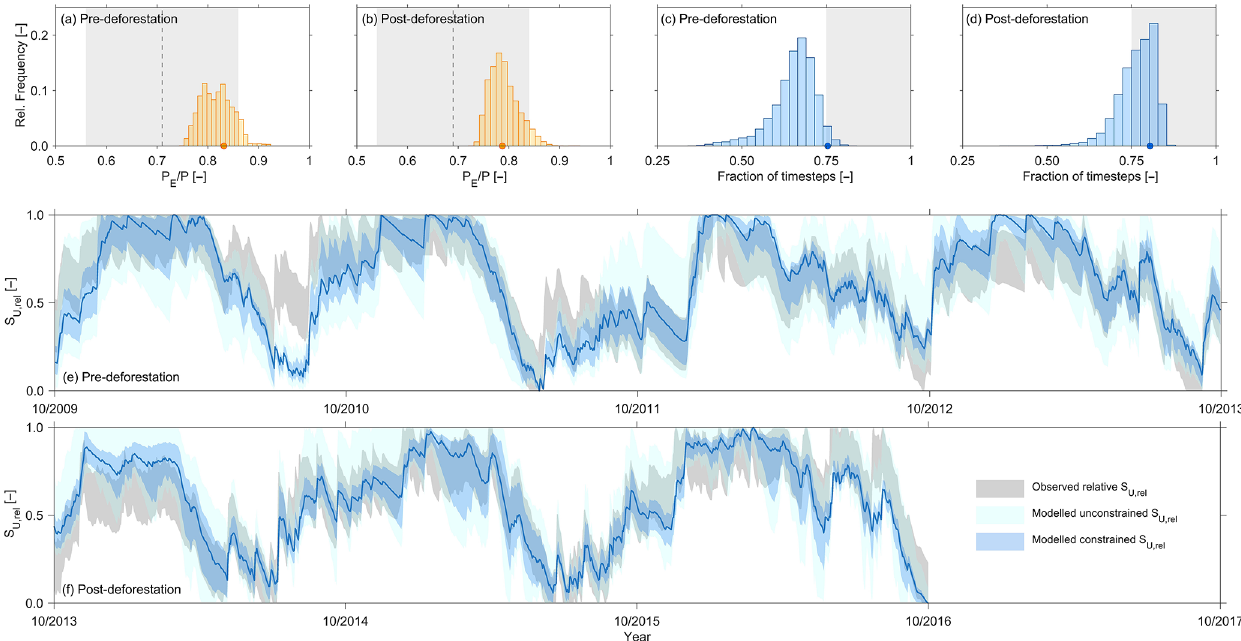
Figure 7. Observed mean P E /P (dashed line), the range around observed mean P E /P defined as acceptable (grey shaded area), the distri- bution of modelled mean P E /P from all solutions that satisfy the behavioural thresholds for all performance metrics (Table 3) as well as the mean P E / of the best solution in terms of D E (orange symbol) for (a) the 2009–2013 pre-deforestation period and (b) the 2013–2016 post-deforestation period. Note that only modelled solutions (yellow) that fall into the acceptable observed range (grey shaded) are kept as feasible. The fractions of time steps in the pre-deforestation (c) and post-deforestation (d) periods in which the modelled relative soil moisture S U,rel falls within the pre-defined acceptable range around the observed relative catchment-average soil moisture. The blue symbols indicate the best solution in terms of D E , and the distributions indicate the set of solutions that satisfy the behavioural thresholds for all performance metrics (Table 3). The grey shaded areas indicate the region of acceptable solutions, i.e. solutions that fall at least 75% of the time steps into the acceptable interval. Note that only modelled solutions (light blue) that fall into the acceptable observed range (grey shaded) are kept as feasible. Pre-deforestation (e) and post-deforestation (f) time series of the acceptable range around the observed normalized, relative soil moisture (light-grey shade) and range of modelled normalized relative soil moisture for all solutions that satisfy all performance metrics (“unconstrained”; light blue) and for the set of feasible solutions that satisfy both P E /P and soil moisture constraints as shown in (a–d) (“constrained”; blue). The dark-blue line indicates the modelled normalized, relative soil moisture of the best solution in terms of D E